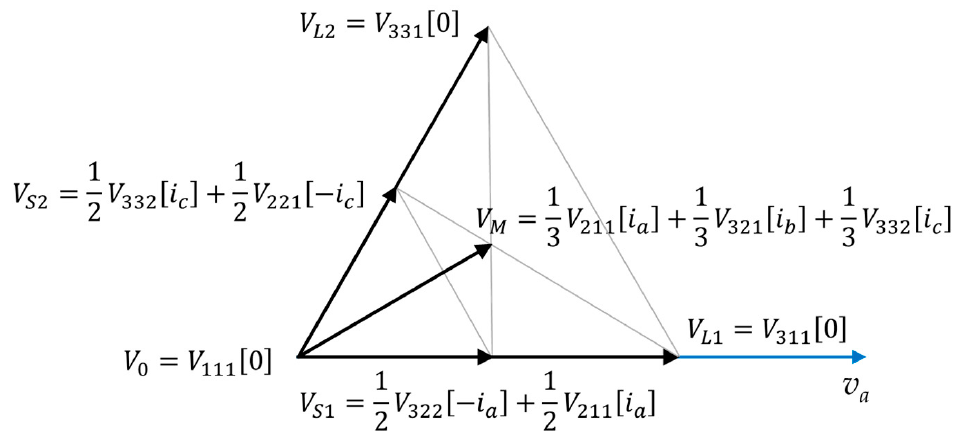
Figure 13. Virtual space vectors defined for the first sextant of the space vector diagram shown in Figure 10 [69].